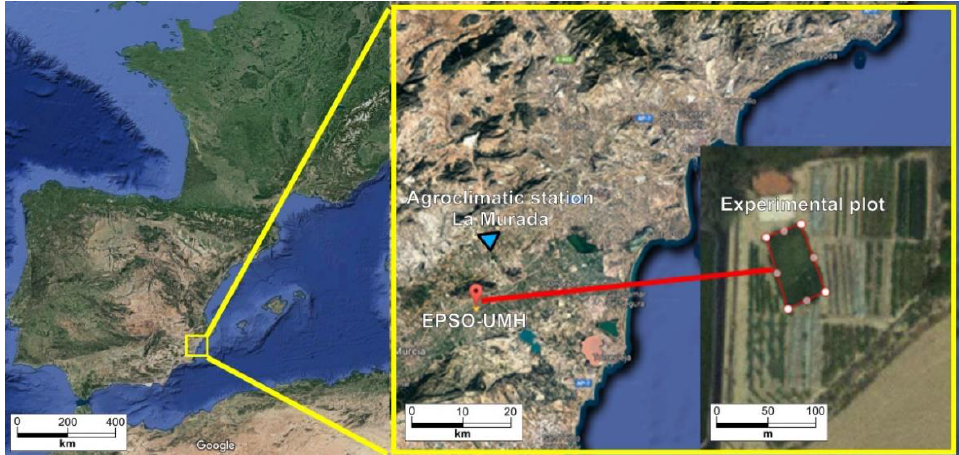
Figure 1. Location of the experimental plot in the Higher Polytechnic School of Orihuela (EPSO) of the Miguel Hernández University of Elche (UMH), Spain, and the agroclimatic station of La Murada, Orihuela. Aerial images were extracted from Google Maps.